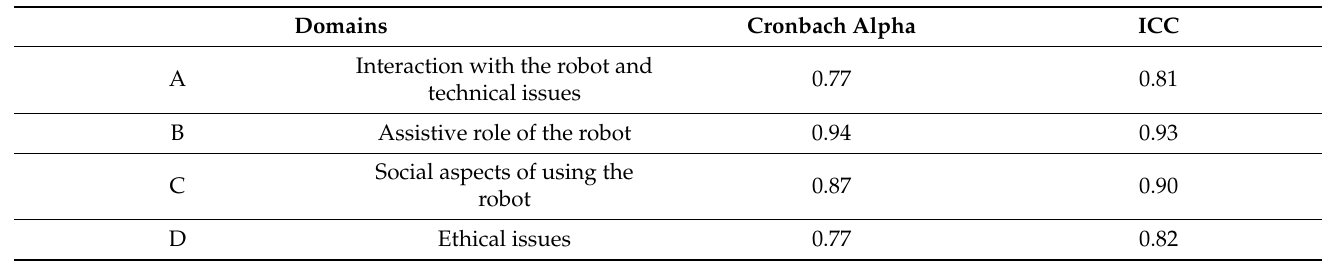
Table 2. The Cronbach Alpha and the Intraclass Correlation Coefficients (ICC) for the domains of the UNRAQ ( n =